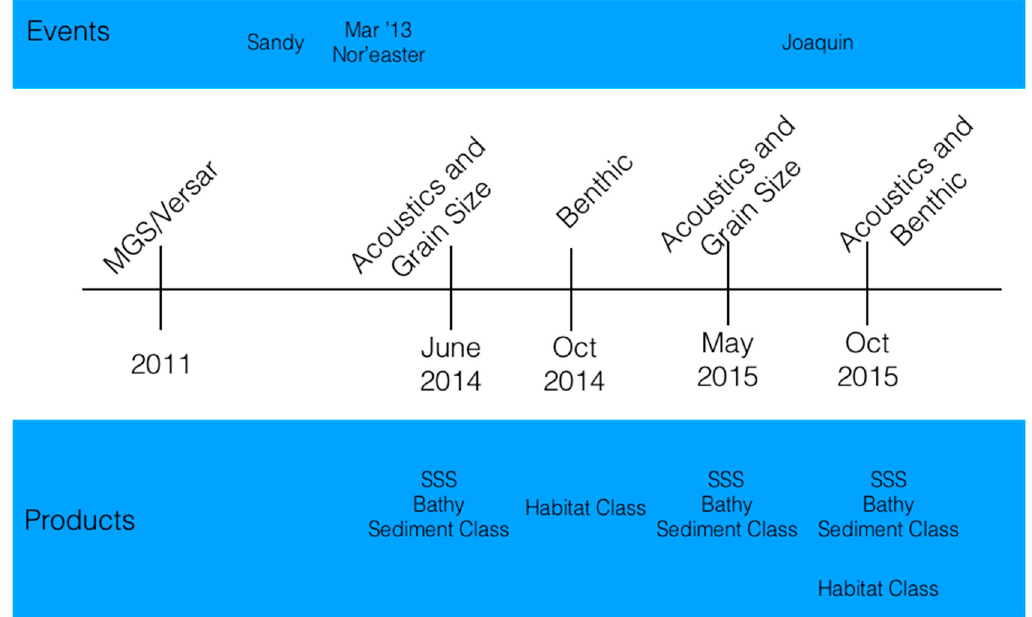
Figure 24. bathymetry profile change after Hurricane Joaquin. Red curved line represents the bathymetry profile J1 in May 2015 and blue curved line represents the bathymetry profile J2 in October 2015. Please note the axial incision in J2 profile.